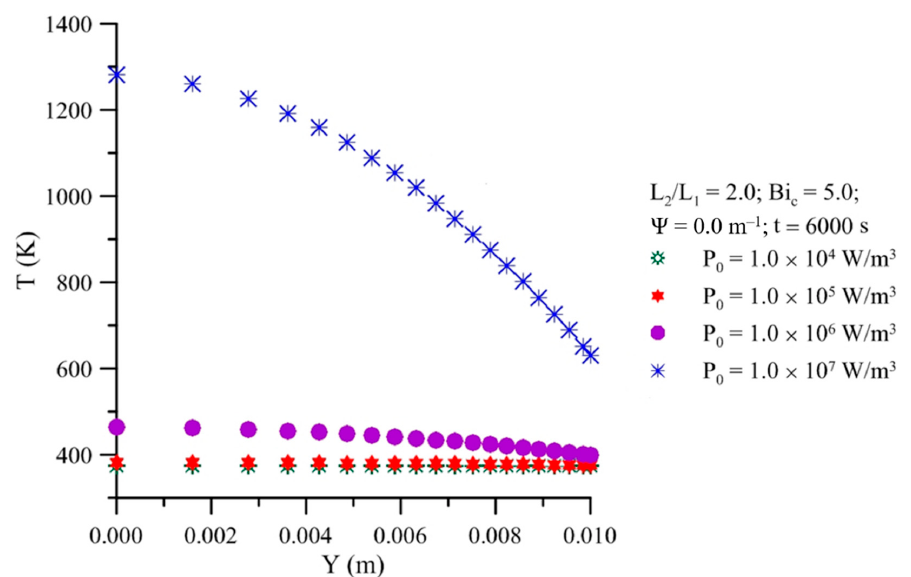
Figure 14. Temperature inside a prolate spheroidal solid with aspect ratio L 2 /L 1 = 2.0, different microwave power densities and fixed heat transfer Biot number ( y -axis, z = 0, t = 6000 s).